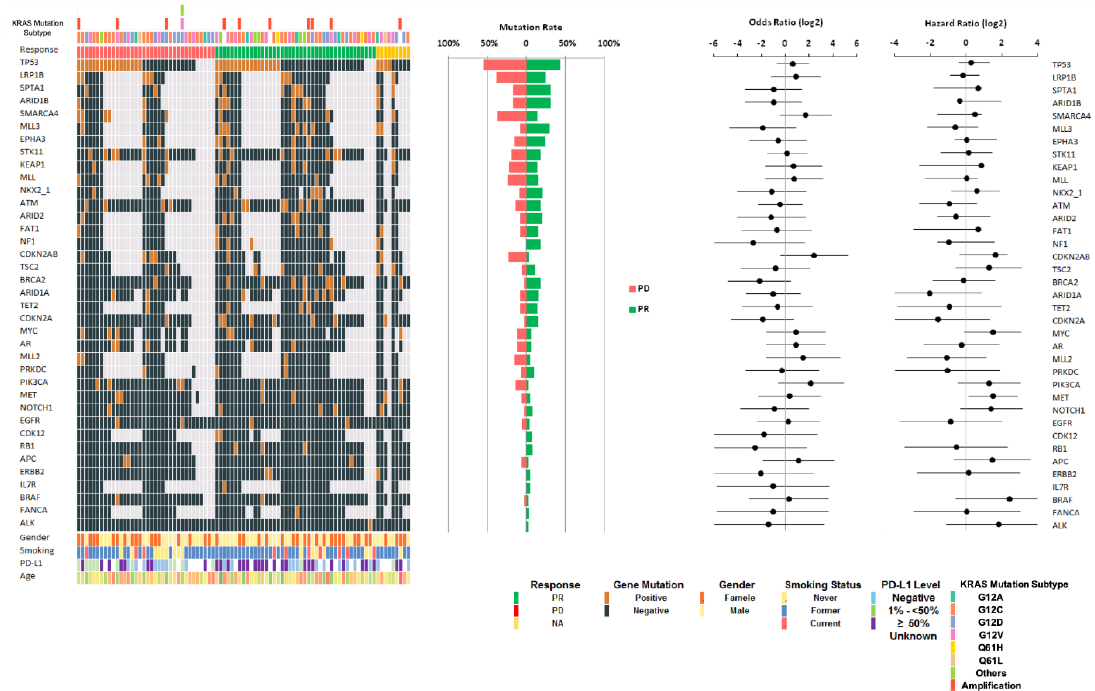
Figure 2. Oncoplot for KRAS common genetic co-occurring mutations (gray signifies that the gene was not tested) and their associations with response (odds ratio) and overall survival (hazard ratio). The results showed CDKN2A/B loss (6/49, 12%), TSC2 (6/52, 12%), TET2 (4/37, 11%), and ARID2 (4/38, 11%). Some KRAS-mutated patients had targetable genomic alterations (GA). A total of 9% of the patients were positive for MET genomic alteration (7/79), in- cluding two amplifications, one exon 14 deletion, one T1010I mutation, one D428G muta- tion, one A347T mutation (Variants of Unknown Significance, VUS), and one T948H mu- tation (VUS). GAs of the EGFR gene were found in 5% of the patients (4/85: 1 patient had E282K mutation, 1 patient had T790M and L858R mutation, and 2 patients had amplifica- tion). In total, 4% had ERBB2 mutation (3/78), including two patients who had amplifica- tion and one who had E645K mutation. A total of 3% of the patients had BRAF amplifica- tion (2/81), and 1% of patients (1/80) were positive for ALK. The univariate COX analysis revealed a statistically significant ( p < 0.05) association between OS and PD-L1 status. Patients with a PD- L1 level ≥50% showed a longer OS com- pared with PD-L1-negative patients (HR; 95% CI; p < 0.01). The median OS for PD-L1- negative patients is 7.1 months. The median OS for patients who had PD-L1 between 1% and 50% is 8.1 months. For patients who had PD-L1 ≥ 50%, the lower 95% CI of the median OS is 19 months (Figure 3A). The median OS was also significantly worse with KRAS comutation CDKN2A/B loss (4.2 vs. 16.9 months, HR = 3.07 (1.09 – 8.69), p < 0.05, Figure 3B) and MET (3.4 vs. 17 months, HR = 3.80 (1.44 – 10.05), p < 0.01, Figure 3C) which were included for the multivariate analysis. The association of OS with other KRAS comuta- tions was not statistically significant, including STK11 (HR = 1.13 (0.43 – 2.97), p = 0.812), KEAP1 (HR = 1.83 (0.51 – 6.54), p = 0.35), ARID1A (HR = 0.24 (0.03 – 1.80), p = 0.166), ATM Figure 3. KRAS comutations with overall survival (OS) and Hazard Ratio. ( A ) OS with PD-L1 status in all KRAS-mutated patients tested ( n = 65). ( B ) OS with CDKN2A/B comutation status in all KRAS-mutated patients tested ( n = 49). ( C ) OS with MET comutation status in all KRAS-mutated patients tested ( n = 78). ( D ) KRAS comutations with Hazard Ratio.